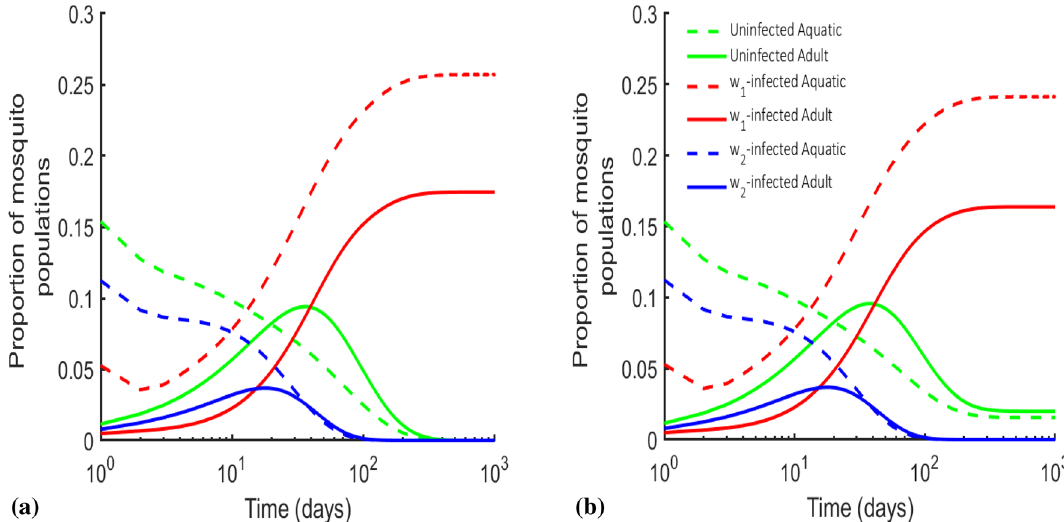
Figure 3. w 1 ( w Au)-infected mosquito equilibrium point e w 1 : The graphs show the local stability conditions for e w 1 . Using ρ u = 10 , ρ w 1 = 40 , and ρ w 2 = 11 , (a) we set η w 1 w 1 = 1 , σ w 1 = 0 and the stability conditions R R R 0 w 1 > 1 , 0 u | w 1 < 1 and 0 w 2 | w 1 < 1 are satisfied. (b) On setting η w 1 w 1 = 0.97 , the becomes unstable and shifts to e uw 1 . Other parameters used are consistent with Table 1. CI Parameters Mosquito Crosses CI type CI effect ( u = uninfected, w 1 = w Au, w 1 = w Mel/ w AlbB) φ uw